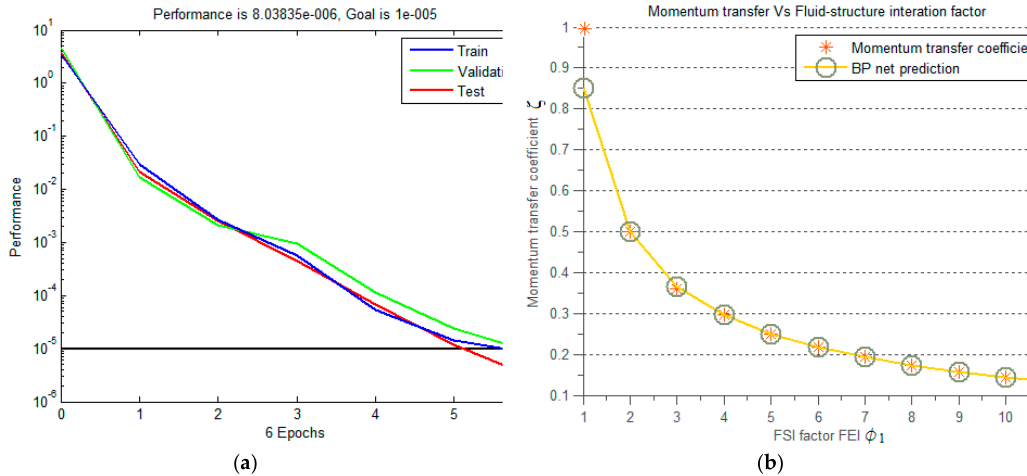
Figure 10. Training process performance curve ( a ) and the BP neural network prediction of momentum transfer ( b ).